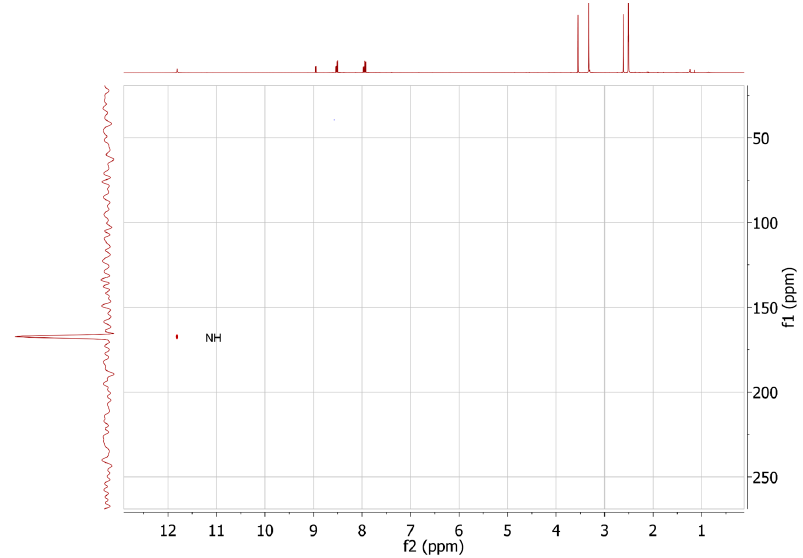
Figure 4. Heteronuclear single quantum coherence (HSQC) experiment showing a sharp peak for the NH of the naphthalimide ring of compound 9a .